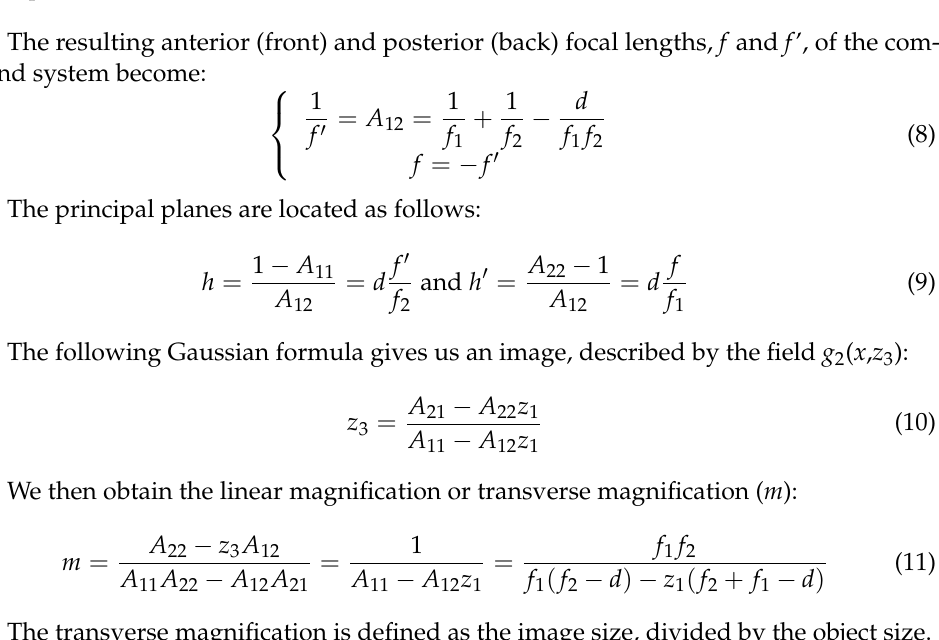
Figure 4. System composed of two special lenses, separated by d , and having different or equal focal lengths, i.e., f 1 and f 2 . For an object g ( x ,0), the output diffraction field g 2 ( x , z 3) could be calculated in four